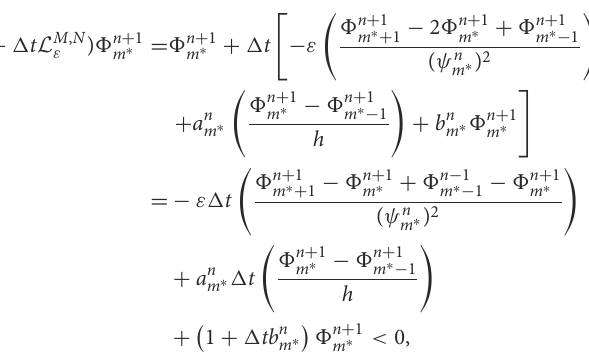
TABLE 4 CPU time for Example